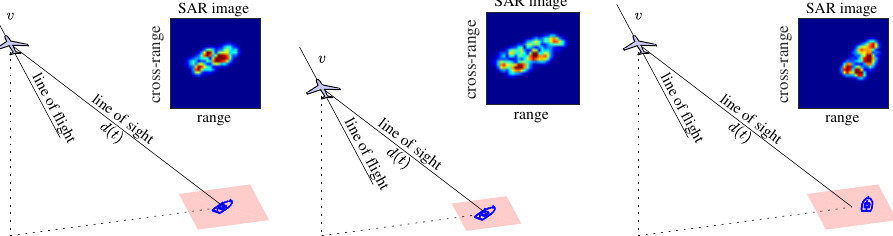
Figure 1. Synthetic aperture radar setup with various relative positions of the radar and the target. The mechanism of SAR imaging ( left ). The emergence of scaling of the target in a SAR image ( middle ). The emergence of rotation and translation of the target in a SAR image ( right